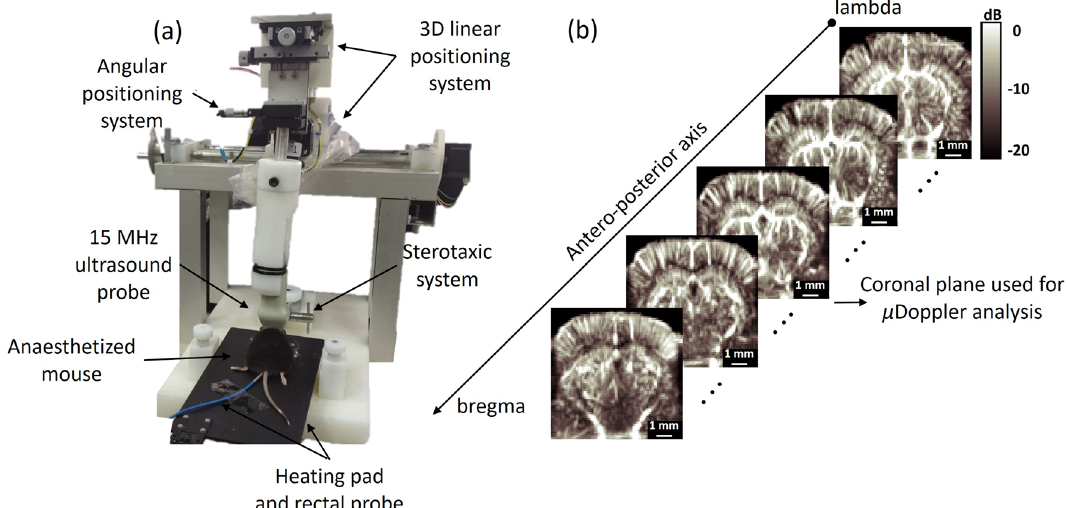
Figure 1. Experimental set-up used in µ Doppler experiments. ( a ) After craniotomy, the anaesthetized mouse was placed in a stereotaxic system. A 15 MHz ultrasound probe driven by a Verasonics system was positioned over the cranial window and aligned to the coronal plane of the brain. Then, the probe was moved along the anteroposterior axis to image the whole brain using a 3D linear positioning system driven by a step-by- step motor. ( b ) In this example we show different coronal planes acquired for a 5-month-old mouse. In this experiment the whole scan consisted of 32 planes separated by 0.1 mm. For the sake of clarity some planes were omitted in ( b